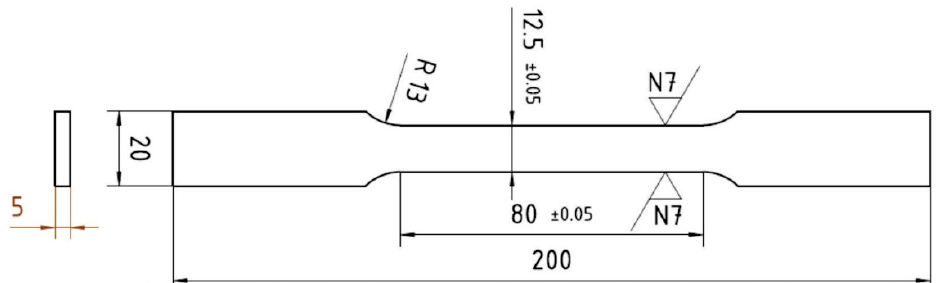
Figure 7. S355J2+N steel specimen shape and dimensions.